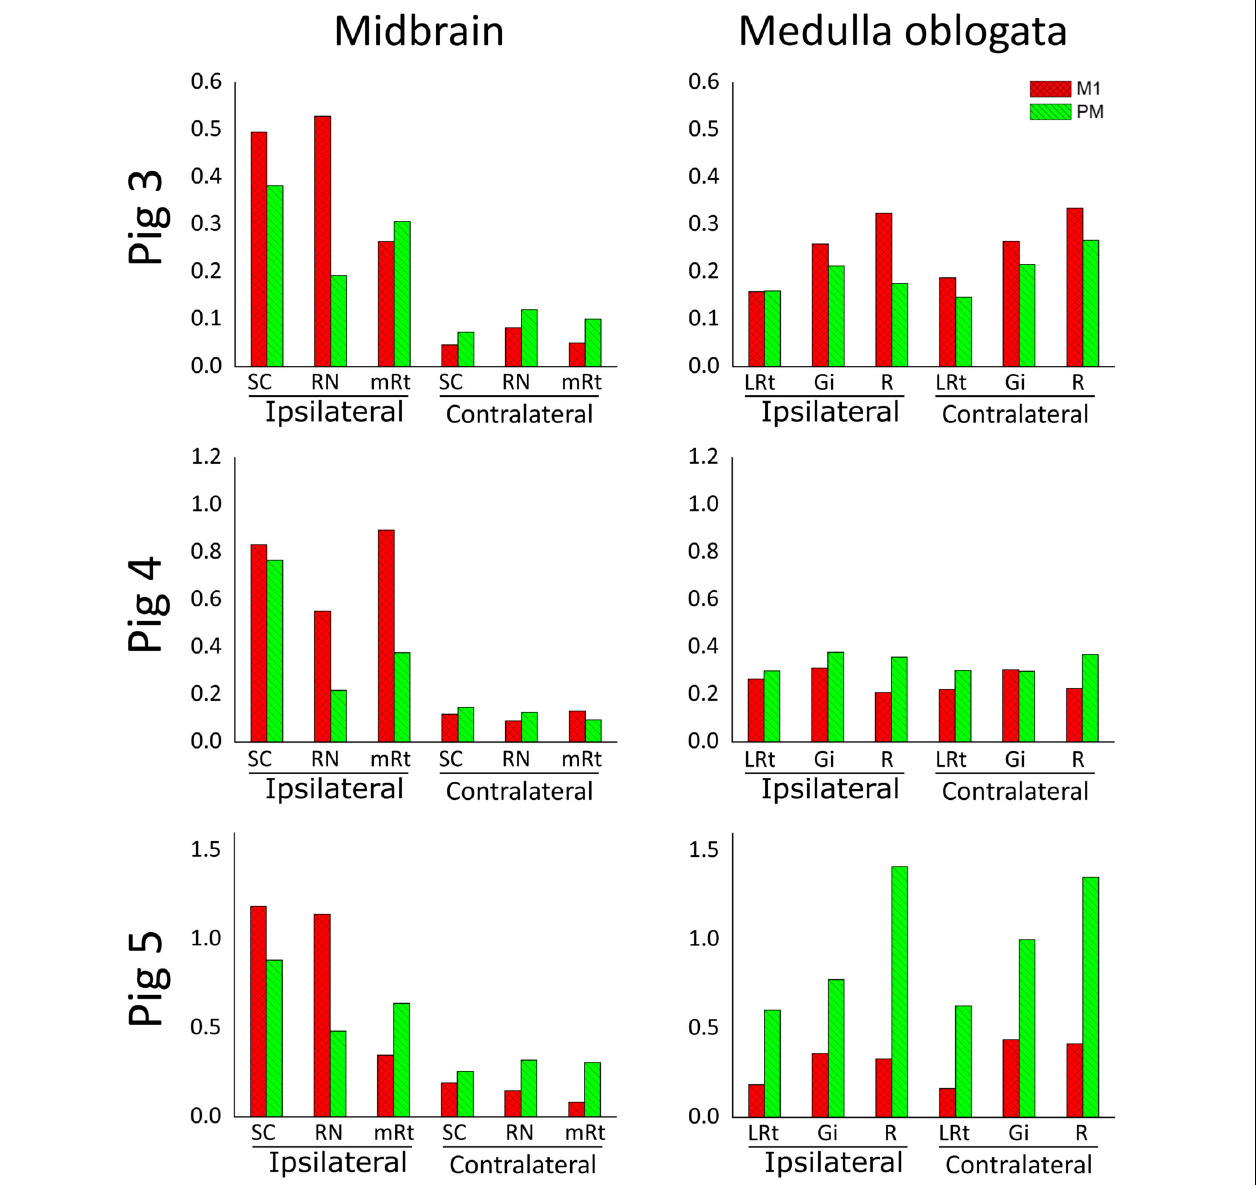
FIGURE 8 | Estimation of brainstem innervation by axons from M1 and PM, represented as the area occupied by CST axonal branches and endings normalized to the amount of CST axons counted in C2. Values from M1-arising axons are shown in red, and those from PM-arising axons appear in green, separately for the side ipsilateral or contralateral to that injected with anterograde neural tracers. SC, Superior colliculus; RN, red nucleus; mRt, mesencephalic reticular formation; LRt, lateral reticular formation; Gi, gigantocellular reticular nucleus; R, raphe